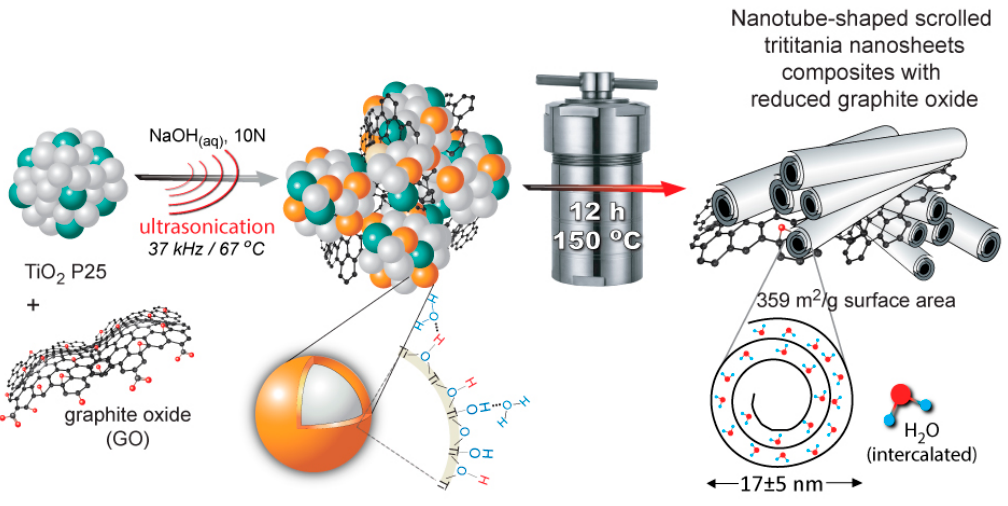
Figure 6. A schematic illustration presenting the followed steps for the synthesis of composites of titanate nanotubes (scrolled titanate nanosheets in nanotubular shapes) with reduced graphite oxide as filler (TiO-NTbs@rGO). Reprinted with permission from Ref. [111]. Copyrights Elsevier, 2021.